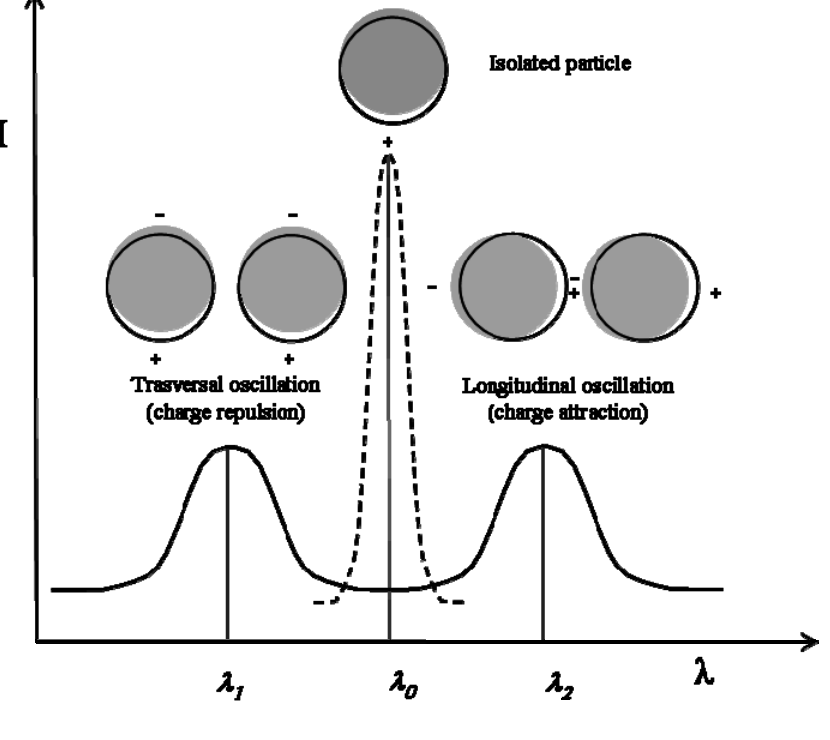
Figure 3. Schematic representation of the splitting in the surface plasmon absorption of a spherical particle caused by the interaction with another particle (actually, the real splitting is not